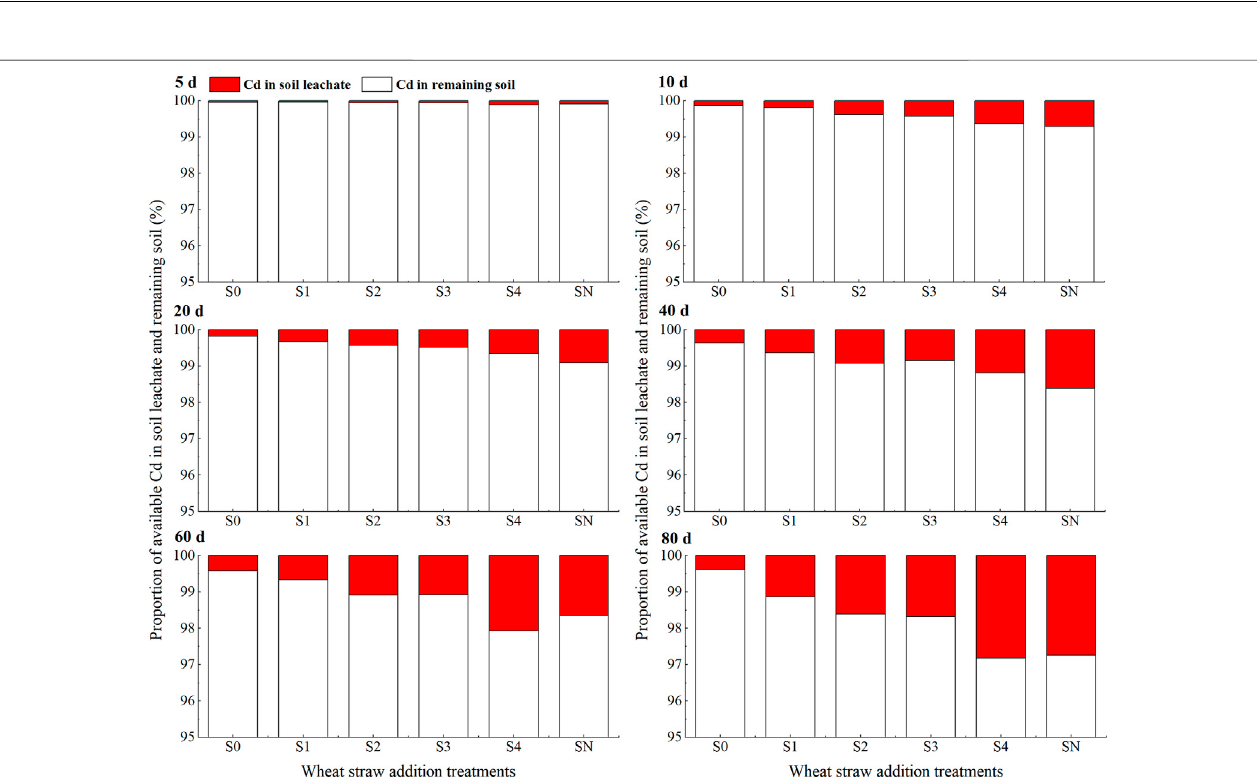
FIGURE 3 | Effect of wheat straw addition on the distribution of available Cd in soil leachate and remaining soil.